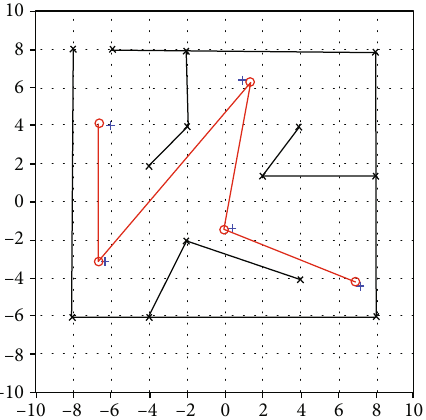
Figure 10: Improved algorithm control results.